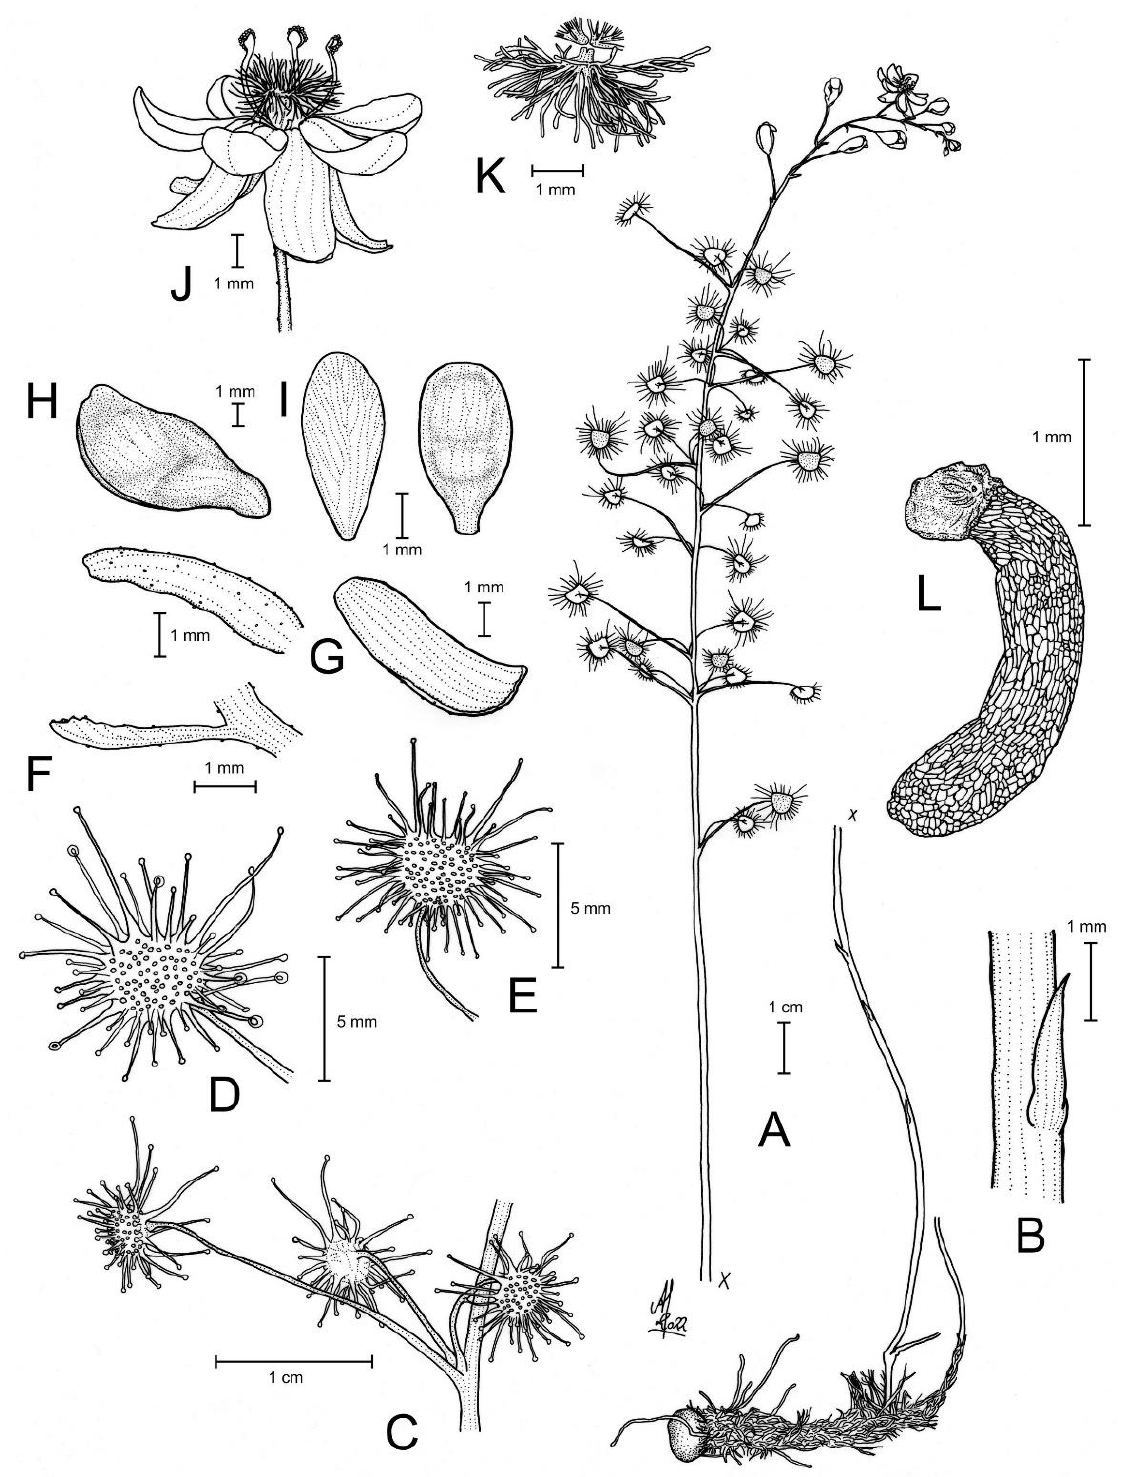
Figure 1. Drosera atrata T.Krueger, A.Fleischm. & G.Bourke. ( A ) habit; ( B ) cataphyll from stem base; ( C ) group of leaves from an upper stem internode, comprising one cauline leaf and two axillary leaves; ( D , E ) lamina, abaxial surface, ( D ) from cauline leaf, ( E ) from axillary leaf; ( F ) bract; ( G ) sepals, abaxial view (left), adaxial view (right); ( H , I ) petals, ( H ) semi-lateral view, ( I ) adaxial view (left example spread, right as in living state); ( J ) flower, lateral view (two stamens removed to reveal the ovary); ( K ) styles, two styles only partially shown; ( L ) seed. ( A , B , E , G , I (left)) from the type ( F. Hort et al. FH 4506 ), ( C , D , F , H , I (right), J – L ) from in situ photographs. Drawing: A. Fleischmann.